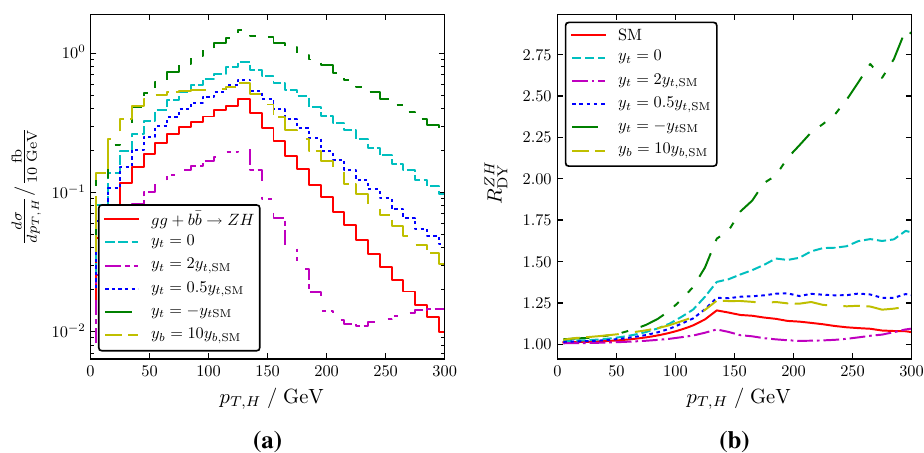
LO (i.e. O (α 2 s ) ) with vh@nnlo [29,30], using PDF4LHC15_nnlo PDFs with α s ( M Z ) = 0 . 118 in both cases [26]. The (local) minimum at p T ∼ 230GeV for y t = 2 y t , SM is an effect from the box–triangle